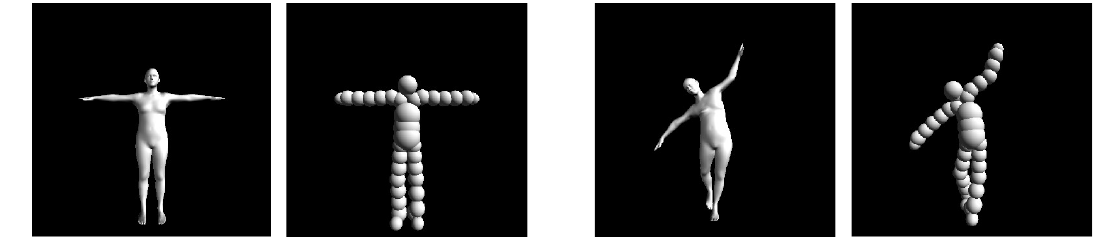
Figure 10. Spheres designed to approximate the human body are kept in the same pose with the body shape